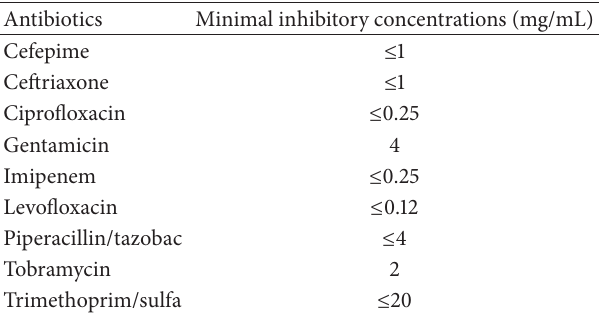
Table 1: Minimal inhibitory concentrations of various antibiotics for Plesiomonas shigelloides